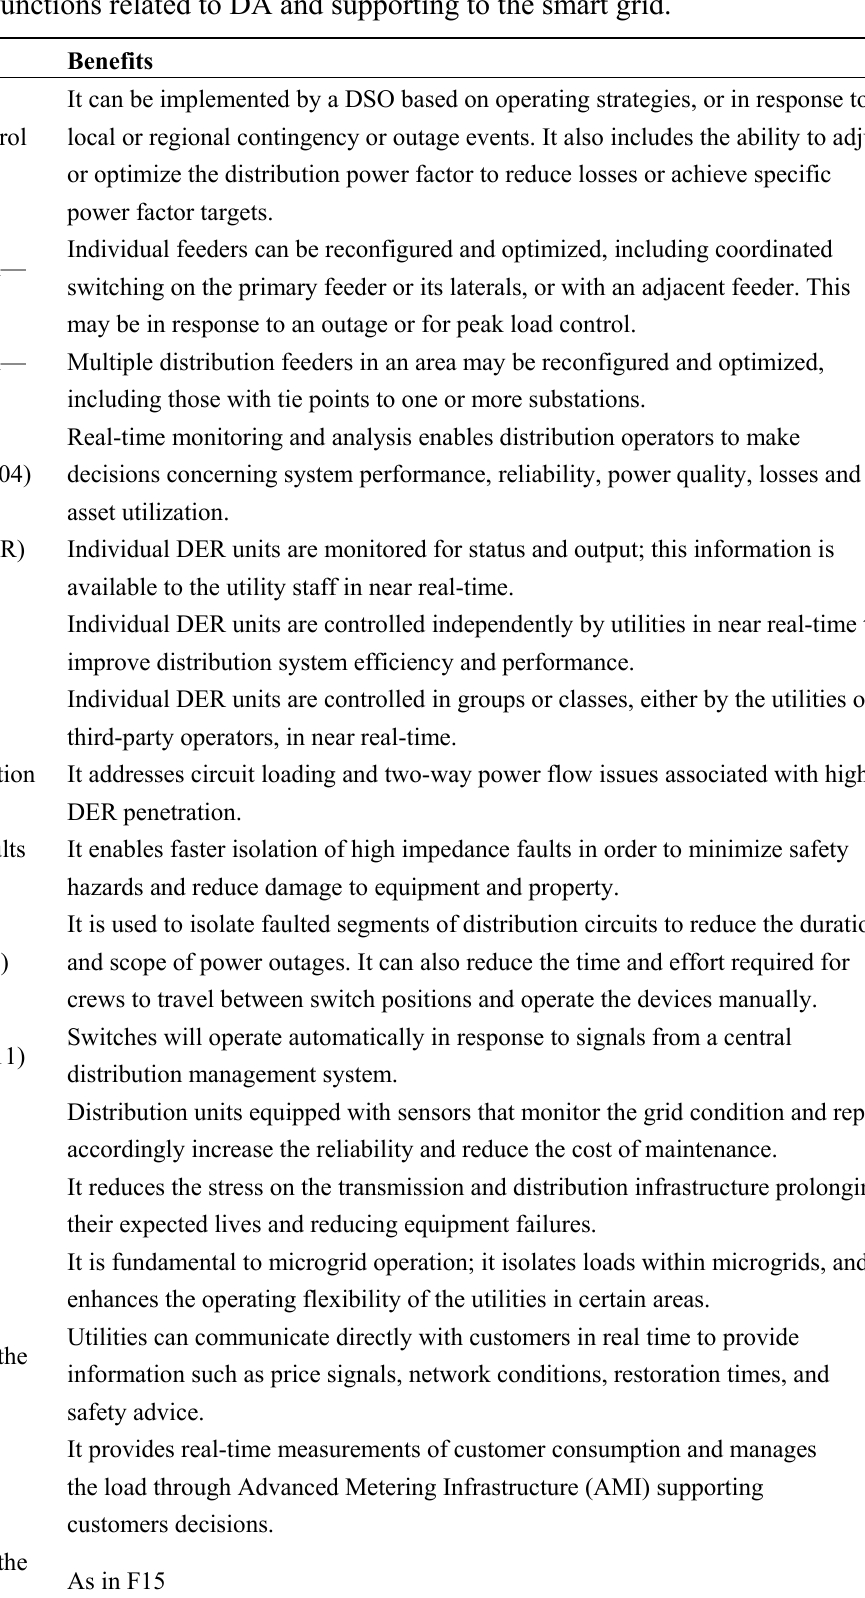
Table 1. Functions related to DA and supporting to the smart